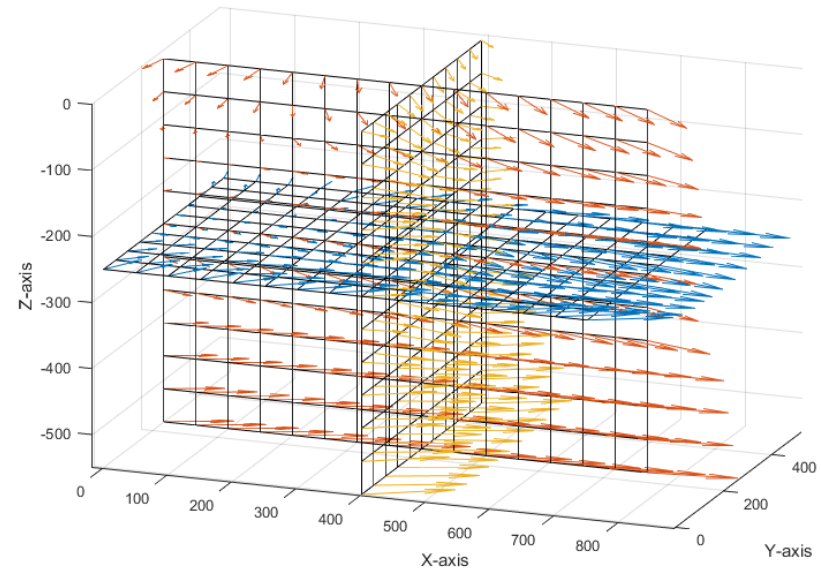
Figure 2. Error vector map (TRAC − CAL), the axes’ units are mm.